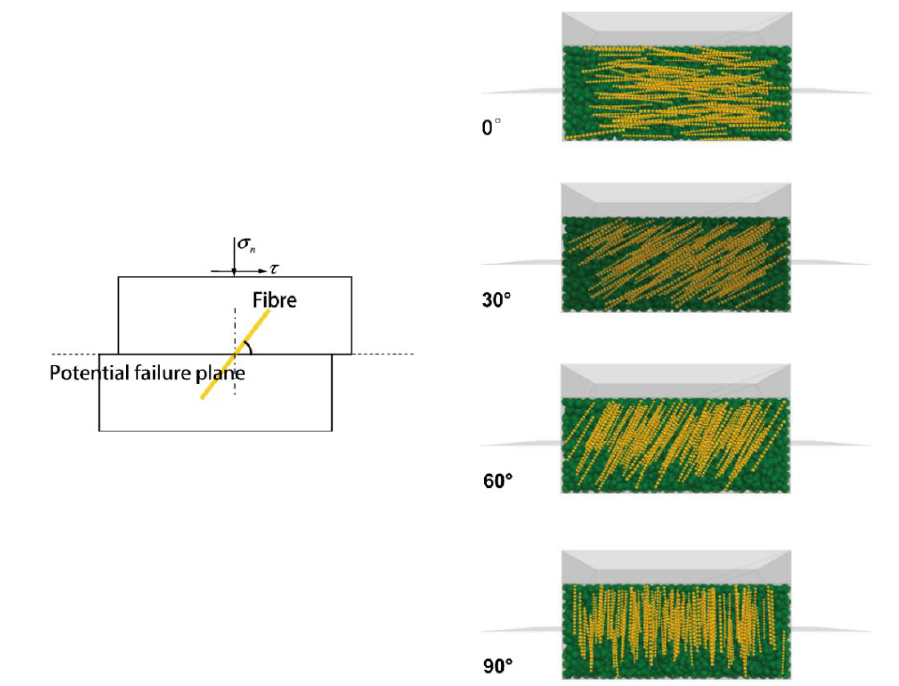
Figure 7. DEM model of FRS with different fiber orientations.